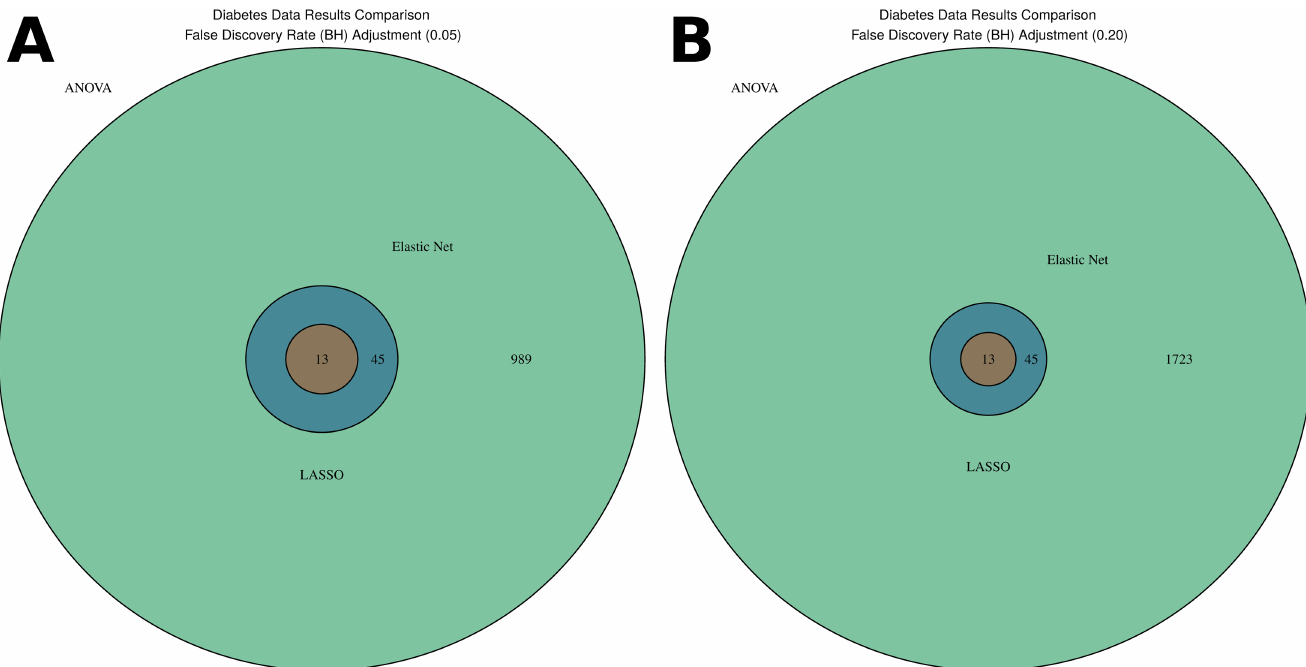
Fig 5. Venn diagrams depicting the results for the maize data. ANOVA (Green), Elastic Net (Blue) and LASSO (Brown) are compared. In Panel A the positive ion mode is shown with an FDR for the ANOVA of 0.05 while in Panel B the negative ion mode is show. Panel C is the positive ion mode with FDR of 0.2 and Panel D is the negative ion